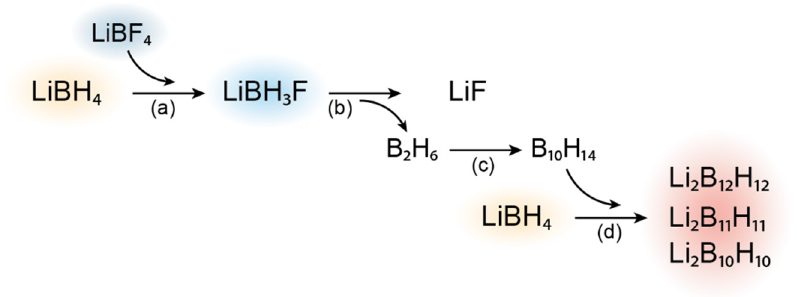
Figure 4. Reaction scheme proposed for the synthesis of LiBH 4 -LiBF 4 solid solutions constituted of multiple closo -borate phases. ( a ) Reaction between LiBF 4 and LiBH 4 yielding unstable LiBH 3 F followed by ( b ) decomposition to form LiF and B 2 H 6 . ( c ) Pyrolysis of B 2 H 6 generating B 10 H 14 in-situ. ( d ) Reaction of B 10 H 14 with LiBH 4 forming several lithium closo -borates. Reaction stoichiometry not taken in account in this overview.